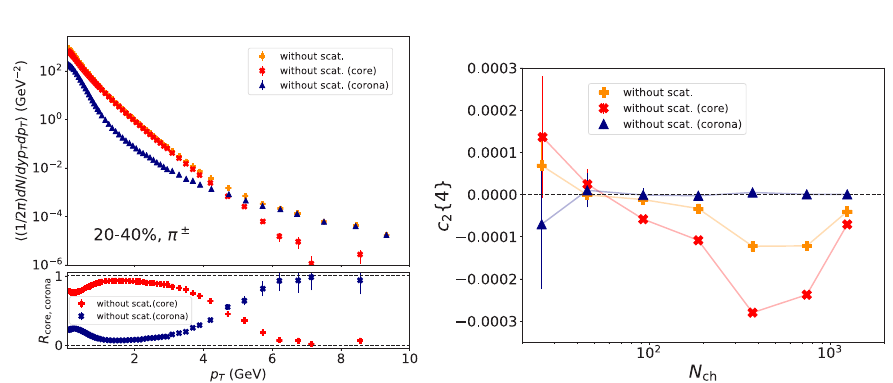
Figure 1. Fractions of hadron yields originating from the core and corona as functions of the number of charged particles η < 0 . 5. Results in produced at midrapidity | | p + p collisions at √ s = 7 and 13 TeV (open squares and triangles, respectively) and Pb + Pb collisions at √ s NN = 2 . 76 TeV (closed circles) are shown.